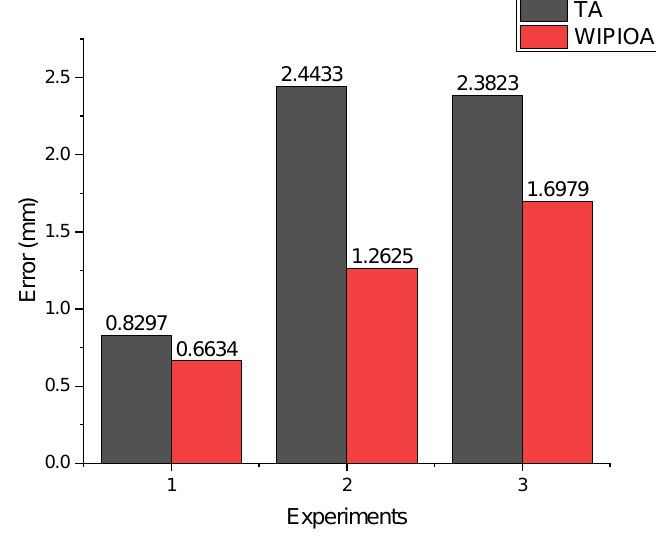
Figure 10. Error